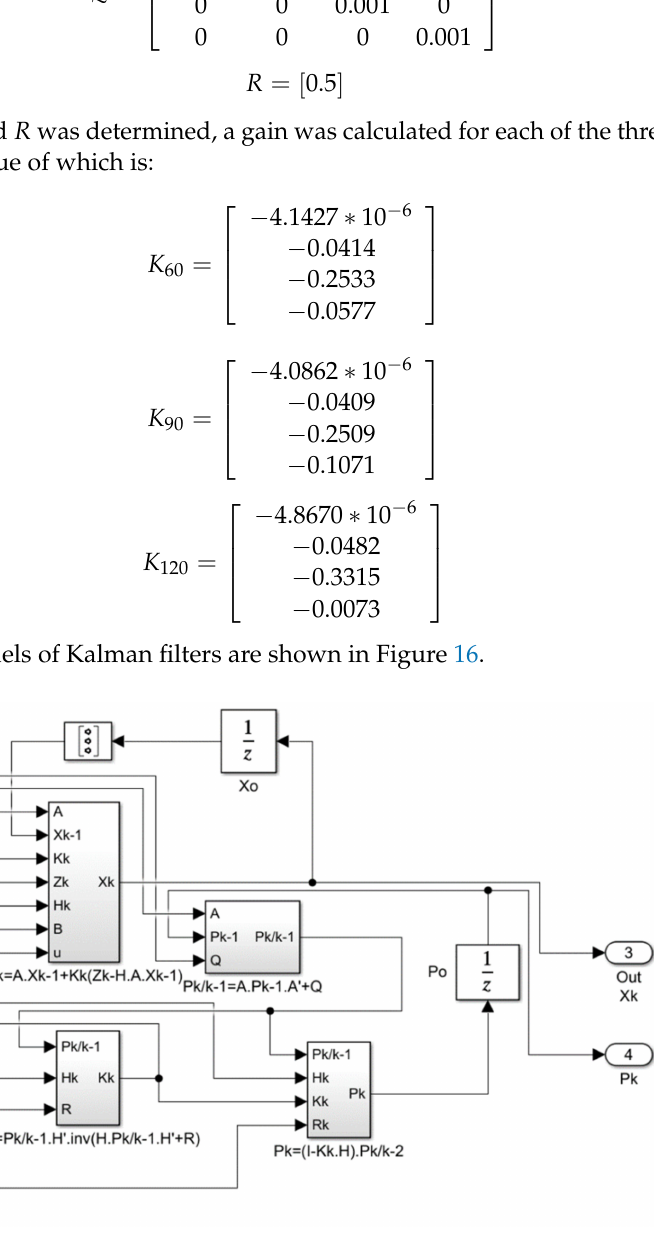
Figure 16. Created model of Kalman filters for UAV